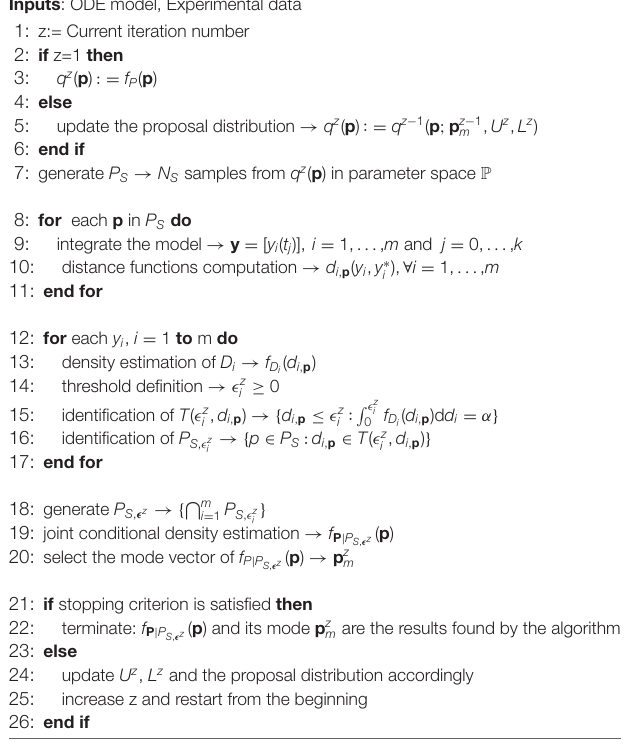
TABLE 1 | CRC algorithm: pseudocode of a generic iteration z of the algorithm. Inputs : ODE model, Experimental